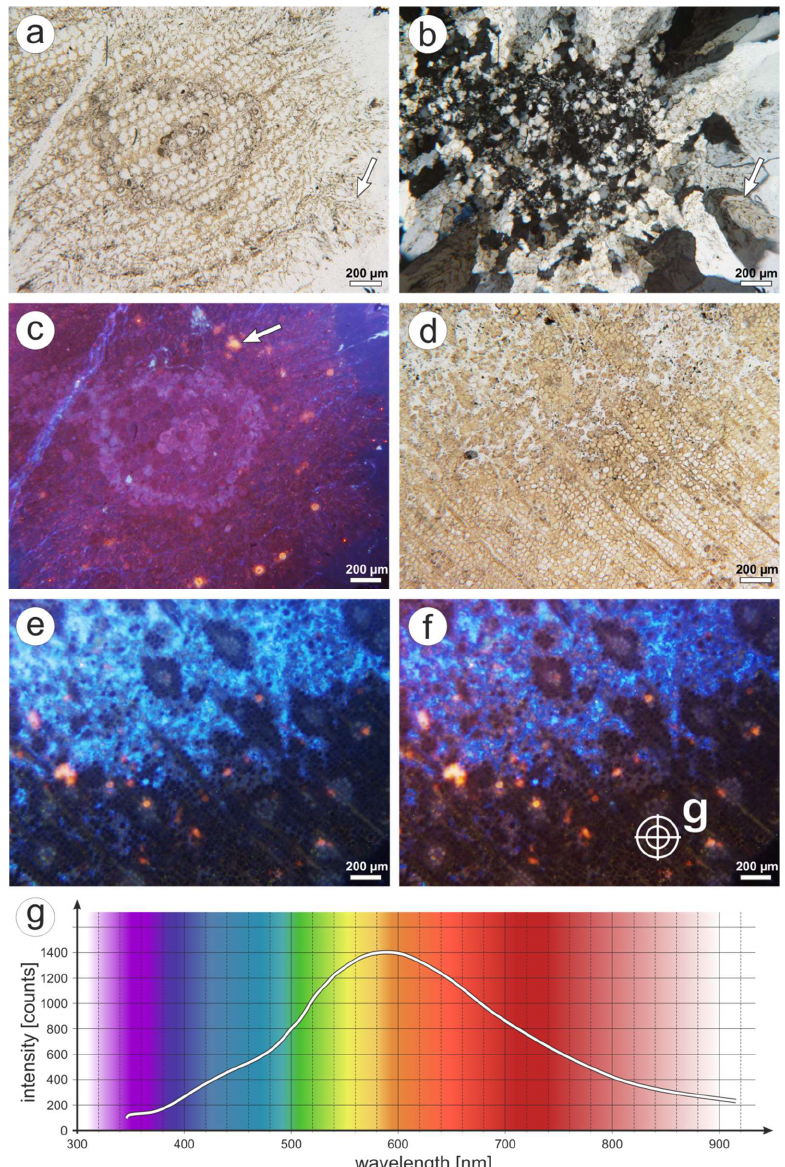
Figure 11. CL of K2097. ( a ) “Point” in PPL. Note highly deformed cells surrounding the “point” (arrow). ( b ) Same view as in (a); XPL image. Each cell is occupied by one quartz crystal in the inner part of the “points”. ( c ) Same view as in a; CL image. The macroscopically visible rings yield different CL intensities under CL. The “point” is rich in yellow halos (arrow). ( d ) “Pointstone” fabric; PPL image. (e + f) Same views as in ( d ). CL images taken initially ( e ) and after three minutes of irradiation ( f ). Note decreasing intensity of blue CL in between the “points”. ( g ) CL spectrum taken at (f).